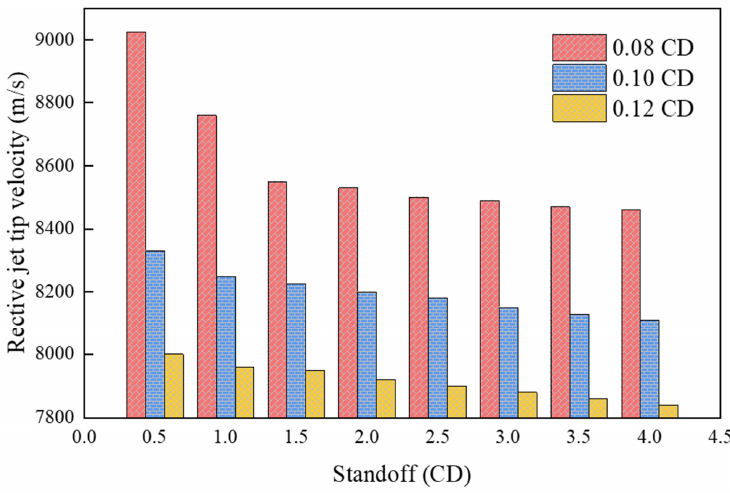
Figure 14. Reactive composite jet tip velocity influenced by the liner thickness.